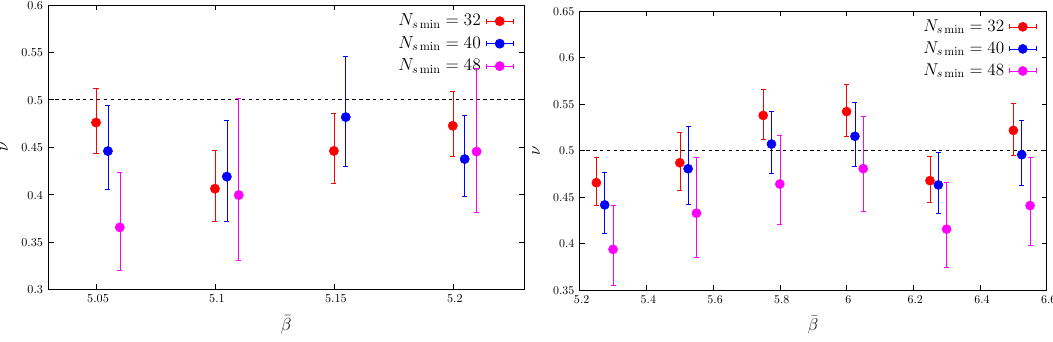
Figure 6 . Critical exponent ν obtained via an unconstrained fit with the function eq. (4.5) to the data for the spectral statistic I λ in the deconfined phase, close to the transition (left panel) and farther above the transition (right panel).